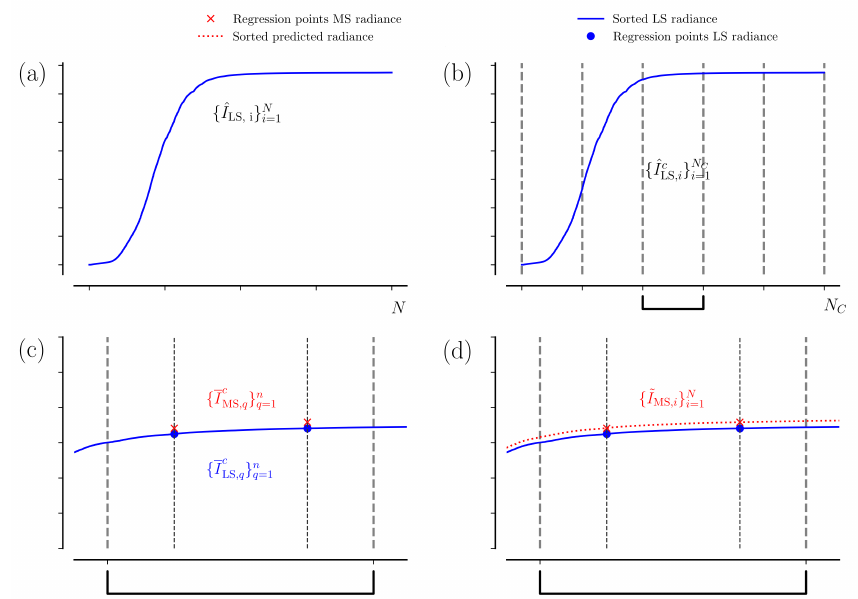
Figure 4. Scheme of the Cluster Low-Streams Regression (CLSR) method. ( a ) Sorted radiance of the low-stream (LS) model in ascending order (blue line). ( b ) Division of the LS radiance in equal clusters C in the sorted domain. ( c ) Zoom for one cluster and the selected regression points of the multi-stream (MS) radiance (red crosses). ( d ) Reconstruction of the MS spectra: the predicted radiance is computed for all the spectral points (dashed red